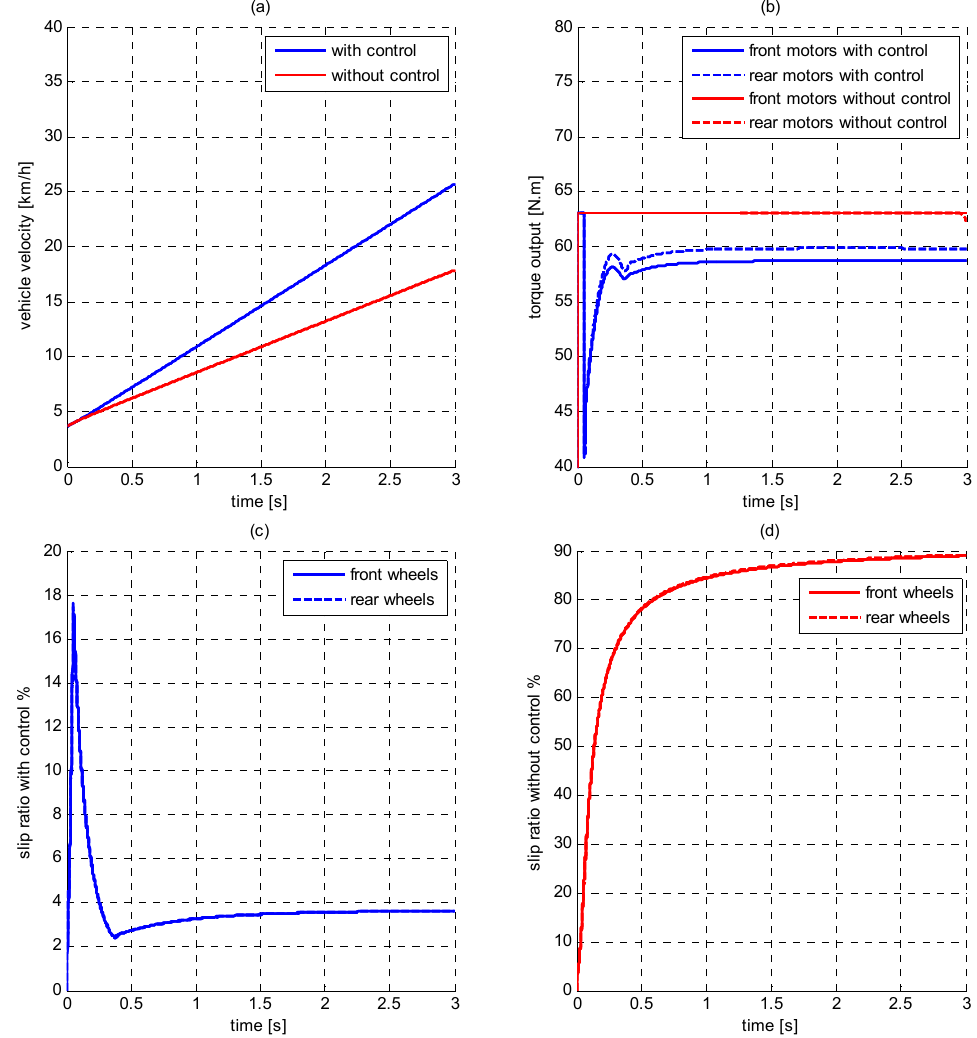
Figure 8. Simulation results of the vehicle with and without pedal self-correcting traction allocation: ( a ) vehicle velocity; ( b ) motor torque output; ( c ) wheel slip ratio with pedal self-correcting traction allocation; and ( d ) wheel slip ratio without control.